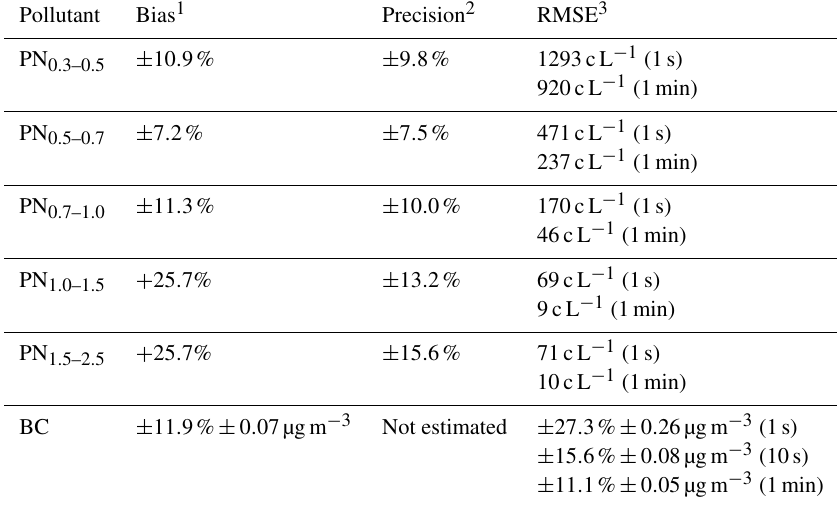
Table 6. Performance of particle instruments (PN and BC) based on collocated parked vehicles. Evaluations performed between May 2016 and August 2017 (Lunden and LaFranchi,